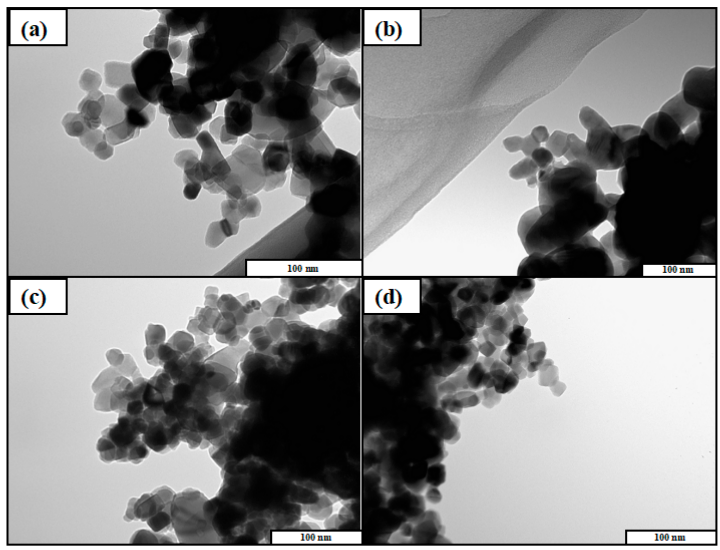
Figure 2. Transmission electron microscope (TEM) images of ( a ) TiO 2 , ( b ) Cu / TiO 2 , ( c ) Ag / TiO 2 , and ( d ) Cu 0.9 Ag / TiO 2 .